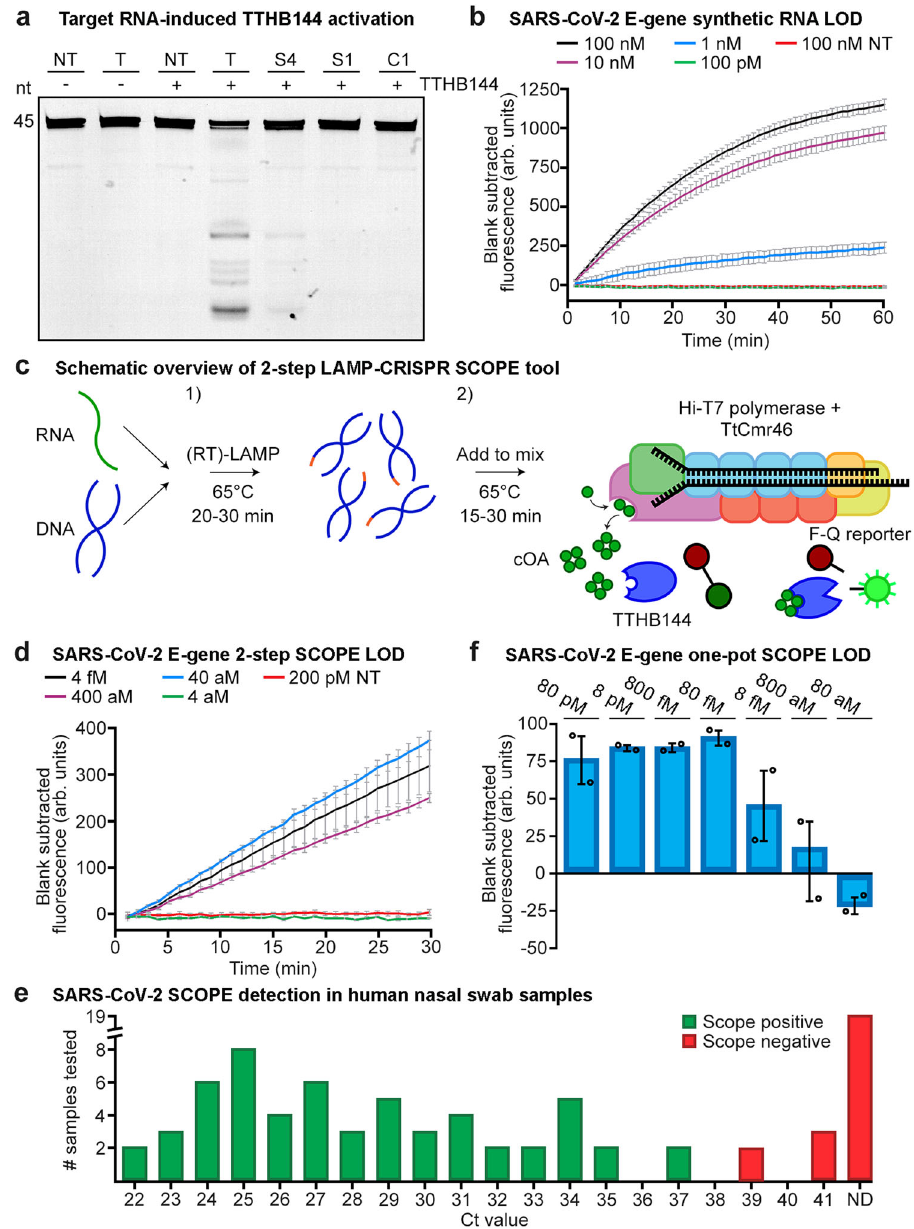
Fig. 5 A novel type III CRISPR-Cas tool for the sensitive detection of nucleic acids. a Denaturing PAGE resulting from activity assays performed with the CARF protein TTHB144 and a 5 ′ Cy5-labeled reporter RNA. Activation of TTHB144 due to cOAs produced by the reconstituted TtCmr-46 complex was monitored by offering fully complementary (T) target RNAs, or target RNA with mismatches in segments one (S1), four (S4) or by a single mismatch in the CAR (C1). A fully non-target RNA (NT) was used as a control. Results of the TTHB144 cleavage assay is representative of results obtained from three replicates (Supplementary Fig. S6). b Limit of detection (LOD) assay using reconstituted Cmr-46 on a synthetic SARS-CoV-2 E-gene and a fl uorophore- quencher reporter RNA masking construct measured over time. A non-target RNA (NT) was used as a control. Data was obtained from three replicates. c Schematic overview of the 2-step reaction setup consisting out of (1) a (RT)-LAMP based pre-ampli fi cation step and (2) a T7-based in vitro transcription and type III CRISPR detection step. ‘ F-Q ’ represents the fl uorophore-quencher reporter RNA. d Limit of detection assay using reconstituted Cmr-46 in the 2-step setup (depicted in panel c ), with a SARS-CoV-2 synthetic full RNA genome as target. Data was obtained from three replicates. e Detection of SARS- CoV-2 in human swab samples. Ct-values of qPCR analysis ( Orf1ab gene) of 81 samples are depicted on the X-axis with the true negative samples displayed as not determined (ND). See Supplementary Fig. S5 and Supplementary Table S2 for Ct-values of qPCR analysis of SARS-CoV-2 samples and respective Scope tool score. The data on the qPCR and SCOPE analysis was obtained from one replicate measurement. f One-pot LAMP-CRISPR limit of detection assay, using reconstituted Cmr-46, on a synthetic SARS-CoV-2 E-gene. Data was obtained from two replicates. All error bars in this fi gure represent the standard deviation of the mean. ‘ Arb. units ’ stands for arbitrary units. Source data are provided as a Source data fi le.